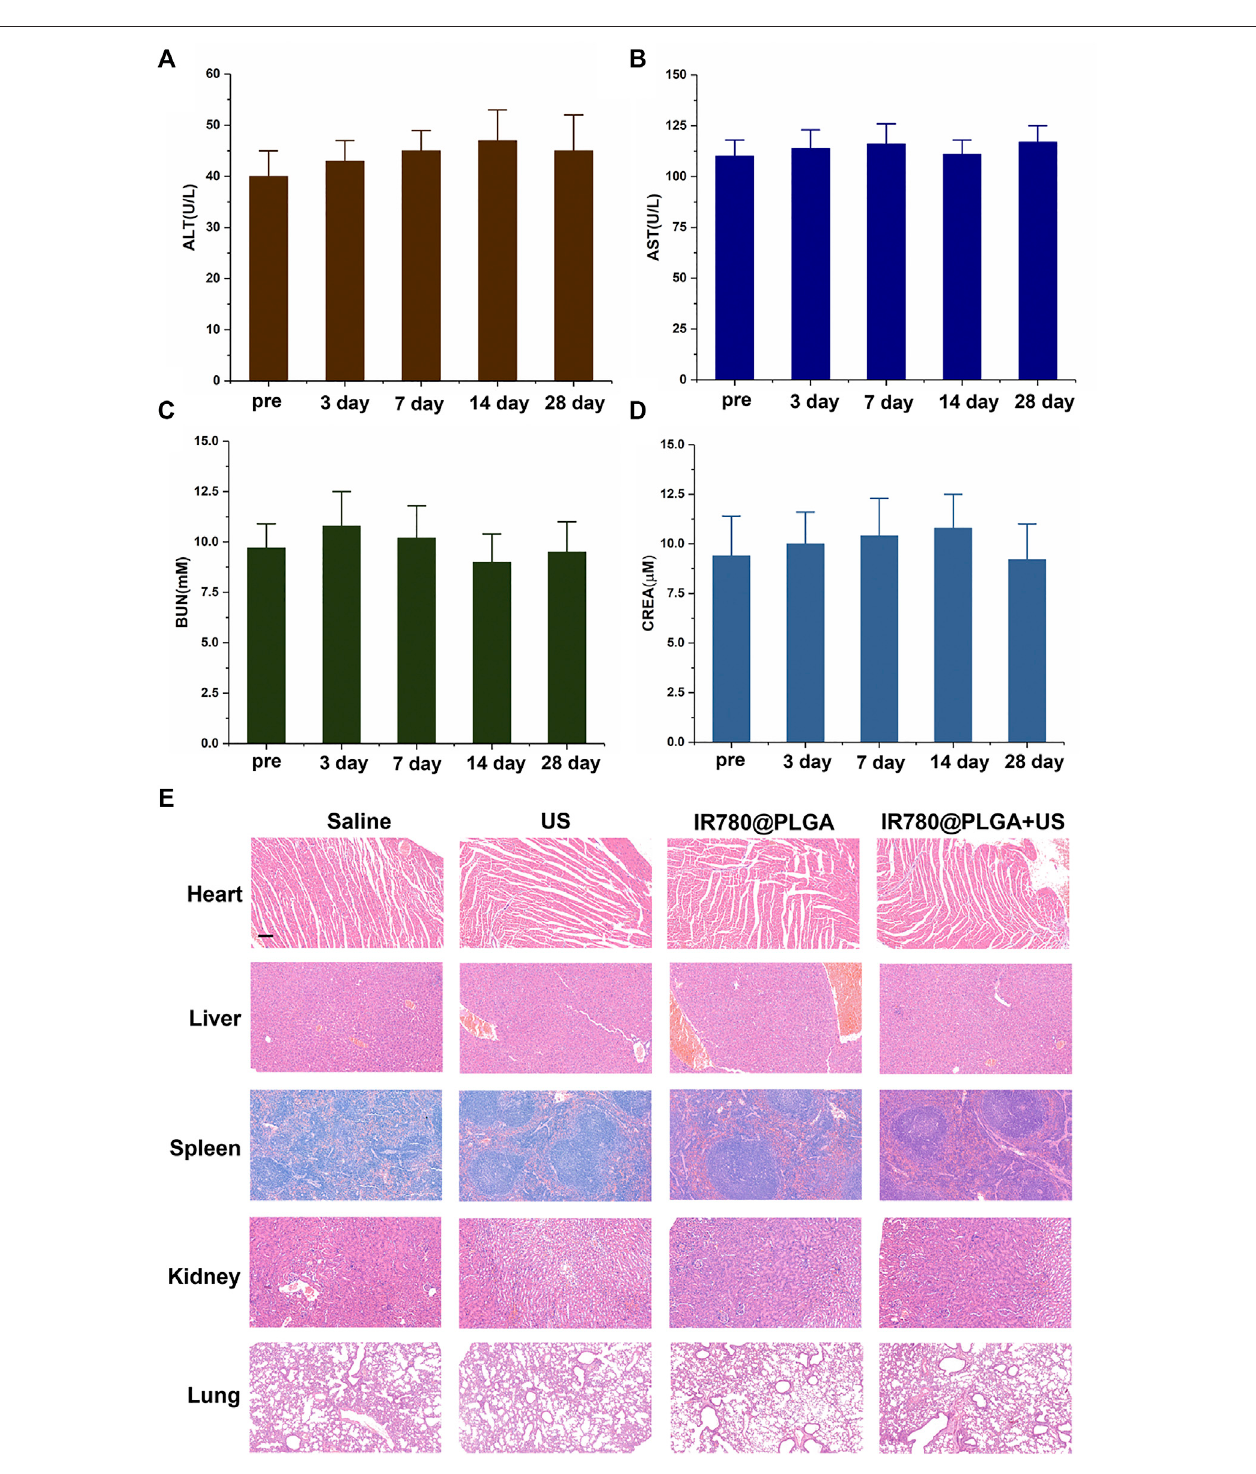
FIGURE 8 | In vivo toxicity study. Serum biochemistry assays including (A) ALT, (B) AST, (C) BUN, and (D) CREA were assessed at 3, 7, 14, and 28 days after injection of nanoparticles; the preinjection of the nanoparticles group was used as a control; the levels of these four indicators were all within normal ranges at different time points ( p > 0.05). (E) H&E staining sections of major organs were harvested at 28 days at different treatments, scale bar = 50 μ m. No noticeable abnormality was observed in the heart, liver, spleen, lung, and/or kidney.